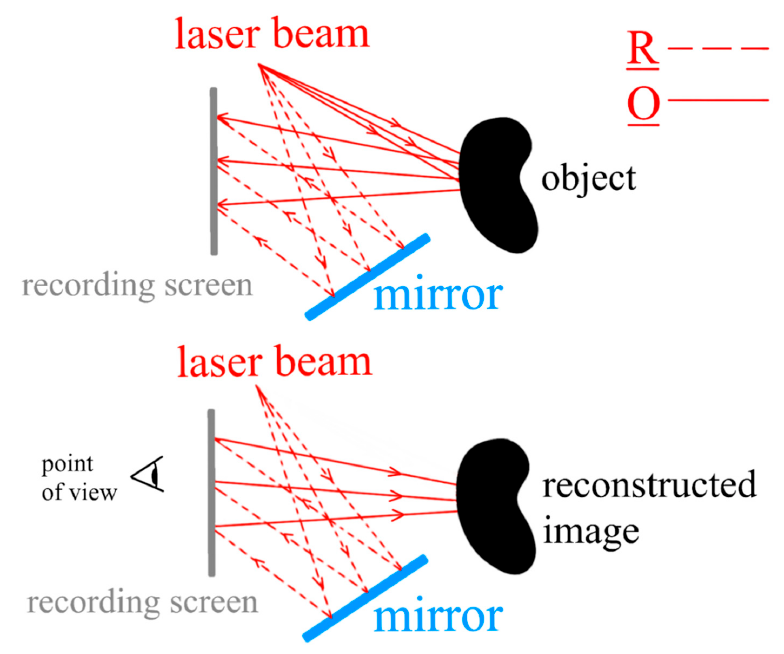
Figure 36. Holography working principle.